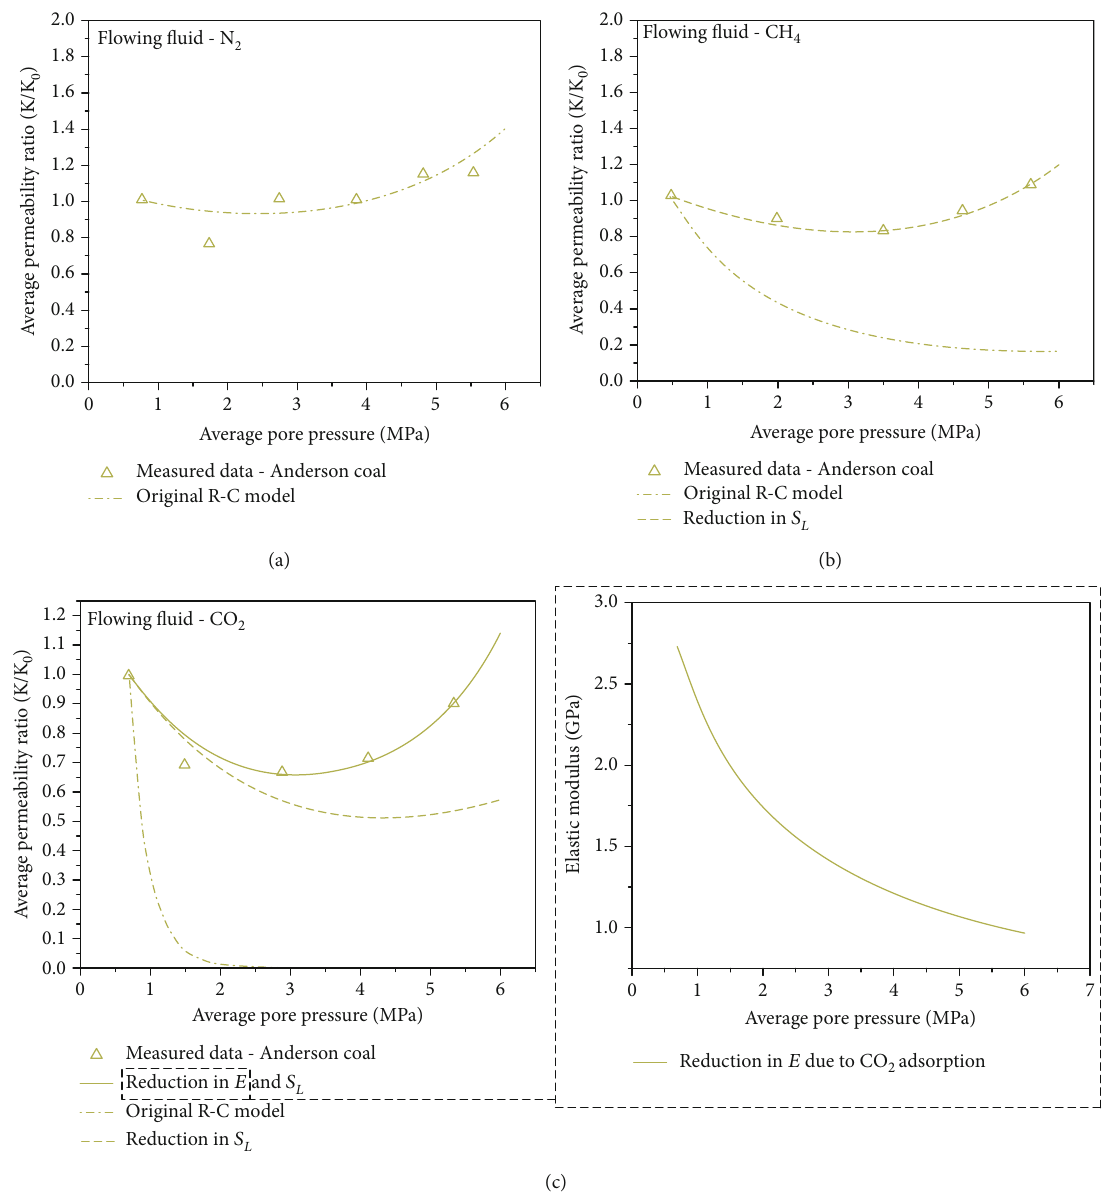
Figure 30: Permeability evolution under di ff erent fl owing fl uid (data from